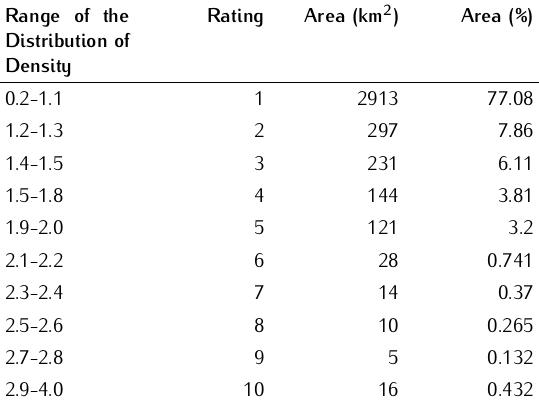
Table 4. Ranges and ratings of lineament density.